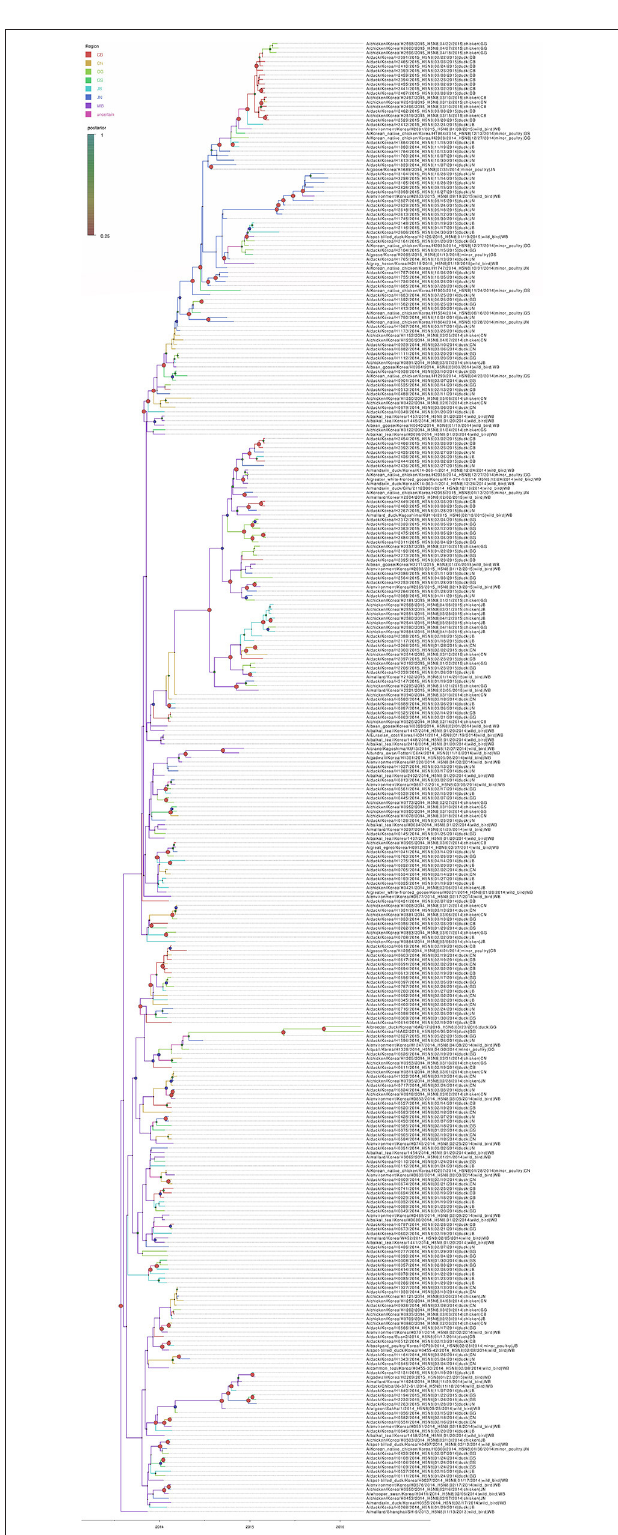
FIGURE 8 | Bayesian phylogenetic tree of the hemagglutinin gene of H5N8 high pathogenicity avian influenza viruses isolated in South Korea during 2014–2016. The geographic regions were defined in the analysis as discrete states. Posterior probabilities of nodes are indicated by the sizes and colors of the